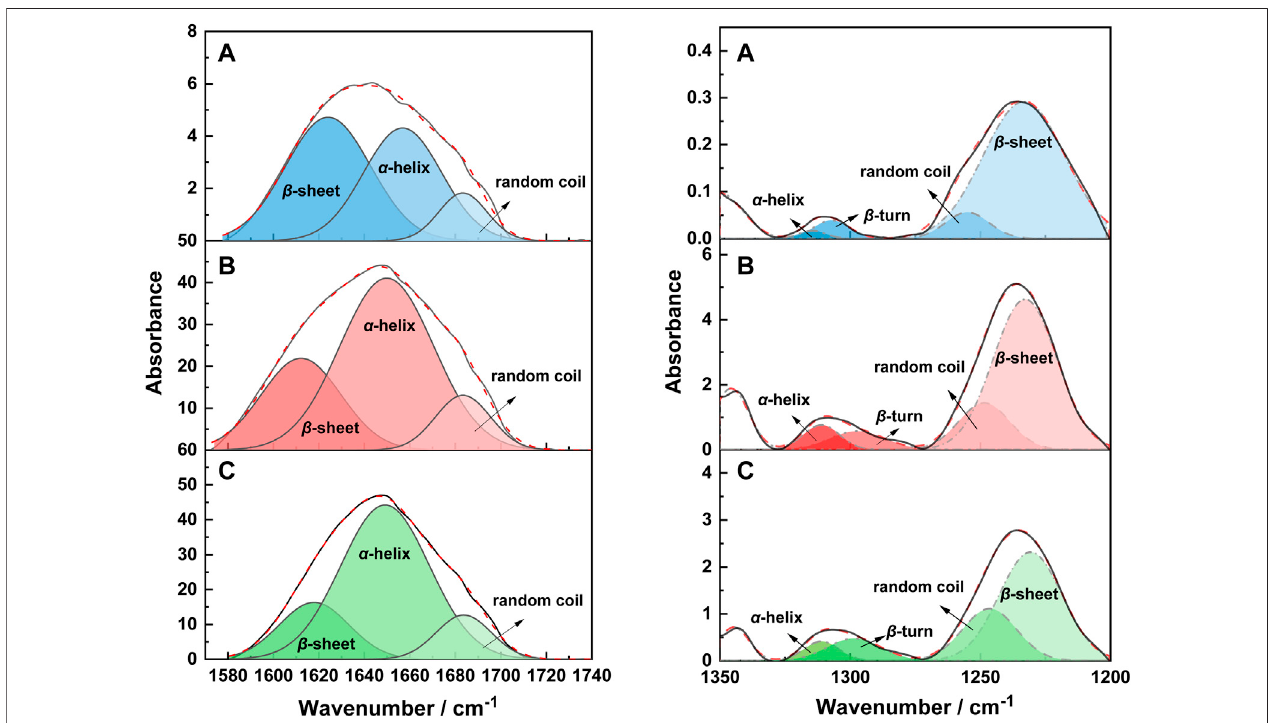
FIGURE 3 | The deconvolution of the amide I and III spectral region of the IR spectra of natural wool (A) , K-C (B) , and K-M (C) .